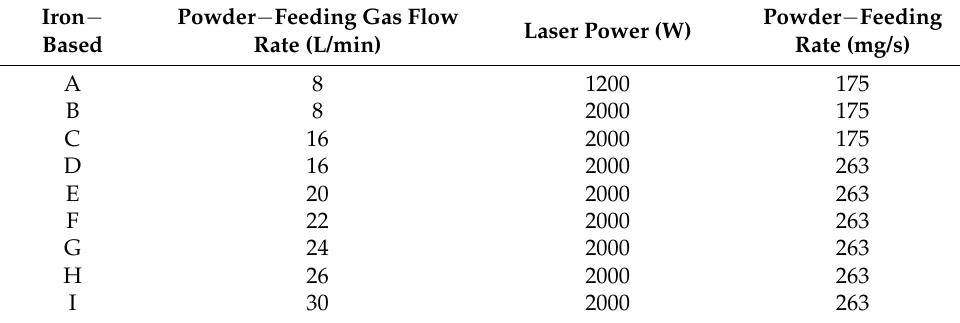
Table 2. Laser cladding parameters